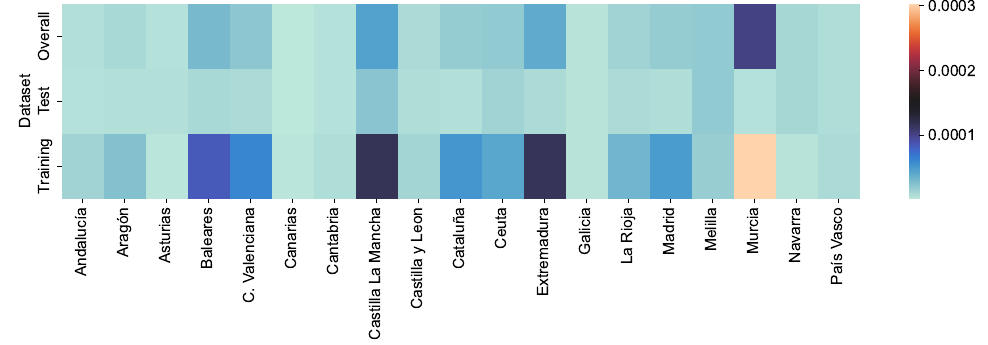
Figure 3. RSME for LSTM networks per Autonomous